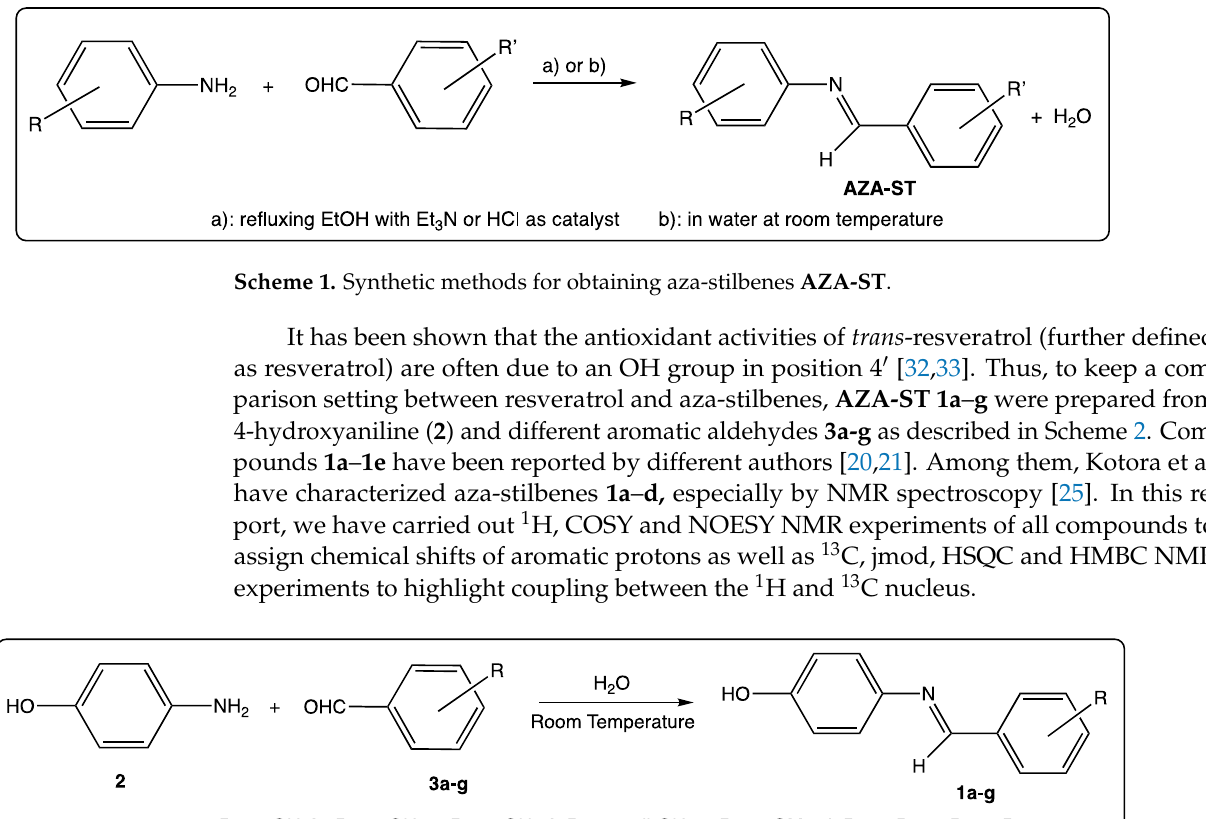
Figure 2. Structure of aza ‐ stilbenes 1a –